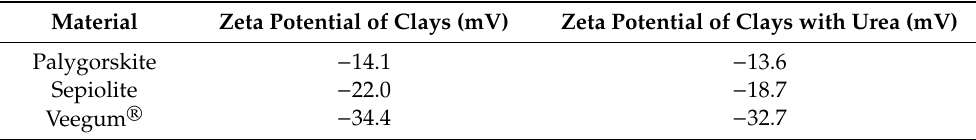
Table 2. Zeta potential of clays before and after urea